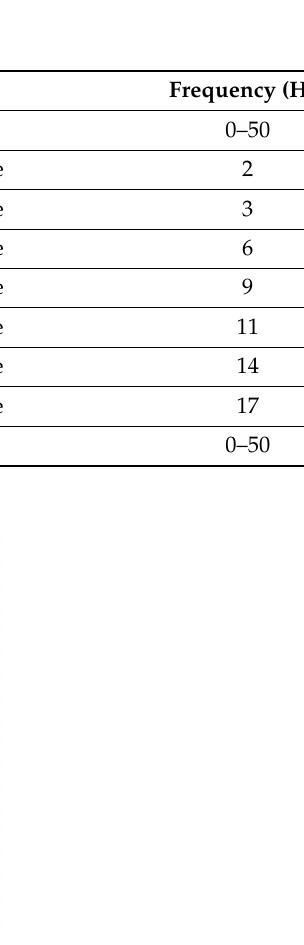
Figure 11. Time history of input motion, with frequency of 2 Hz.